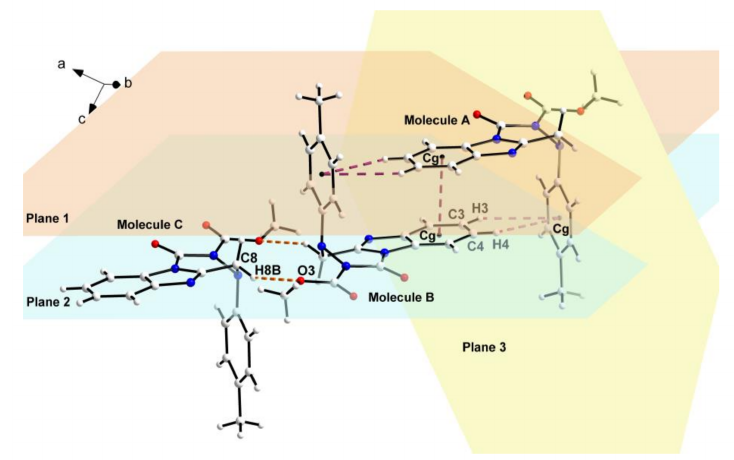
Figure 4. Partial crystal parking diagram of compound 4n . Planes 1, 2, and 3 indicate respectively three planes containing benzimidazole ring of molecule A, benzimidazole ring of molecule B, and benzene ring of molecule A. Table 2. Antifungal activity of compounds 4 against three test fungi at 50 µ g/mL.